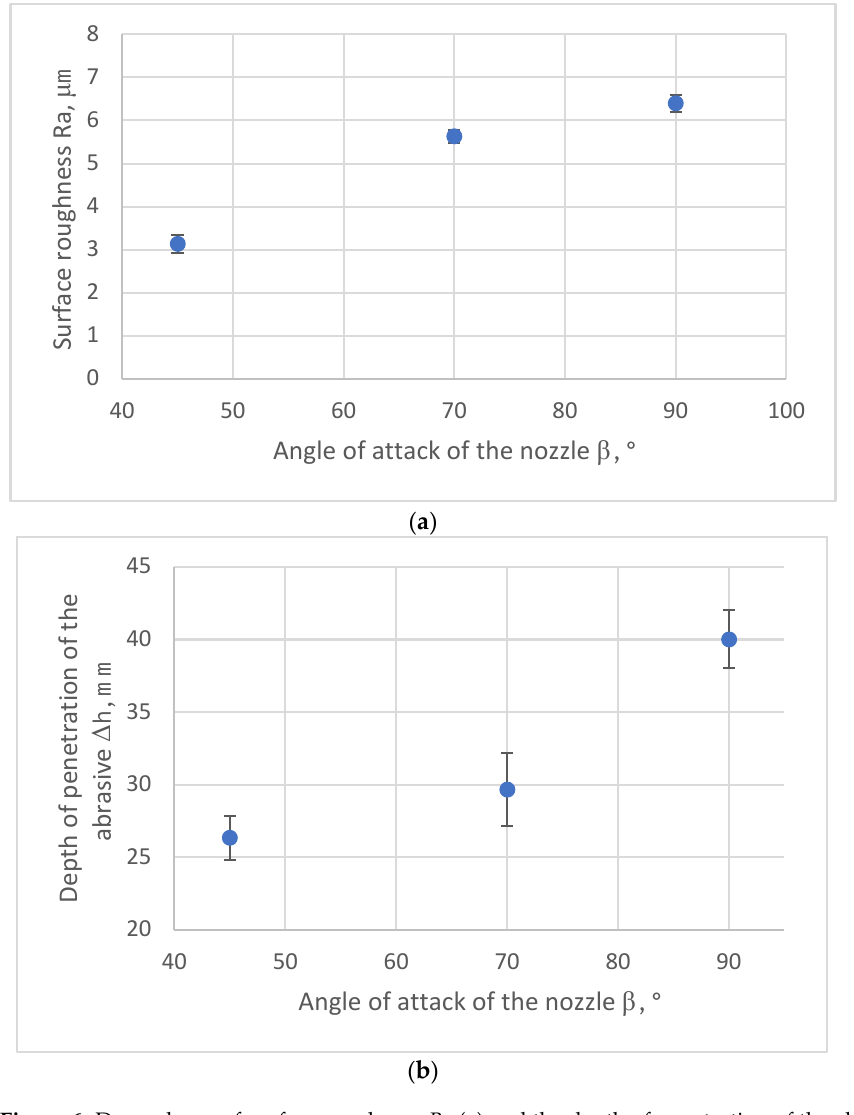
Figure 6. Dependence of surface roughness Ra ( a ) and the depth of penetration of the abrasive ∆h ( b ) on the angle of attack of the nozzle β (air pressure P; processing time t—3 min, 30 s). The standard deviation of surface roughness is the smallest for the 70° angle and is 0.15 µm, and the largest deviation for the 45° angle (0.21 µm).